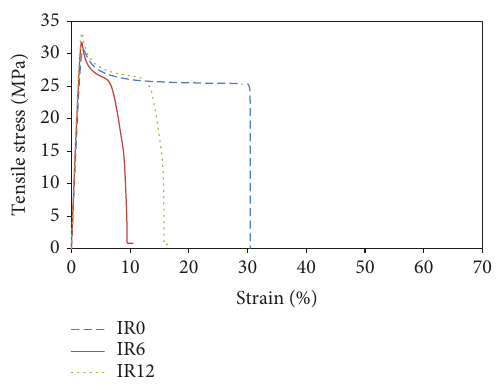
Figure 8: Stress-strain curves of PLA/IR with various mastication